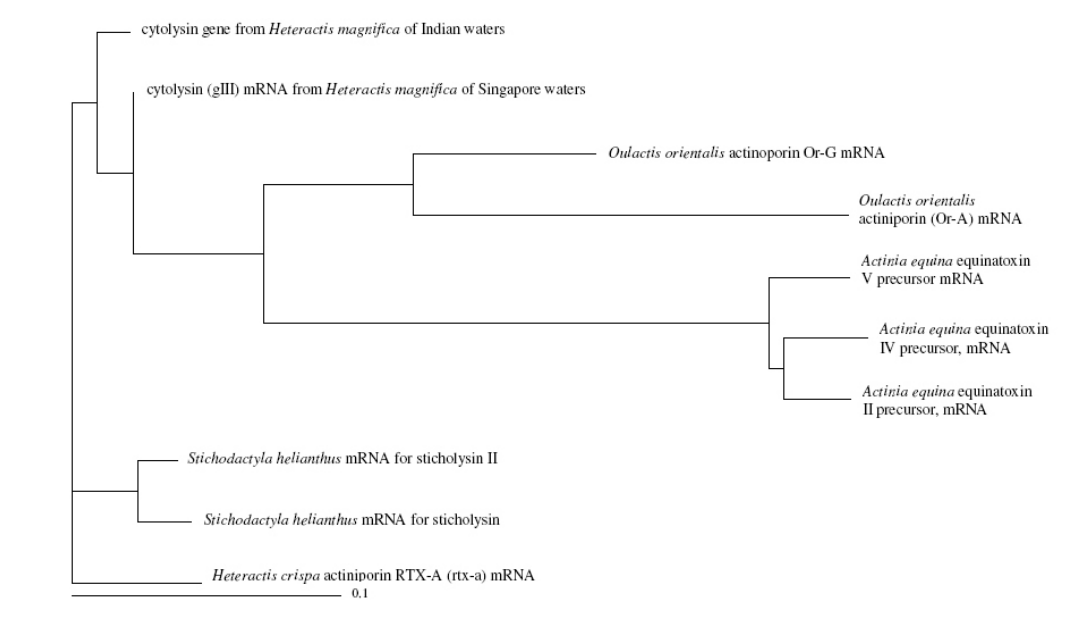
Figure 10. Phylogenetic analysis of the cytolysin gene of Heteractis magnifica with the other reported cytolysins from sea anemones. The H. magnifica cytolysin showed close relationship with sticholysin and actinoporin RTX-A, rather than